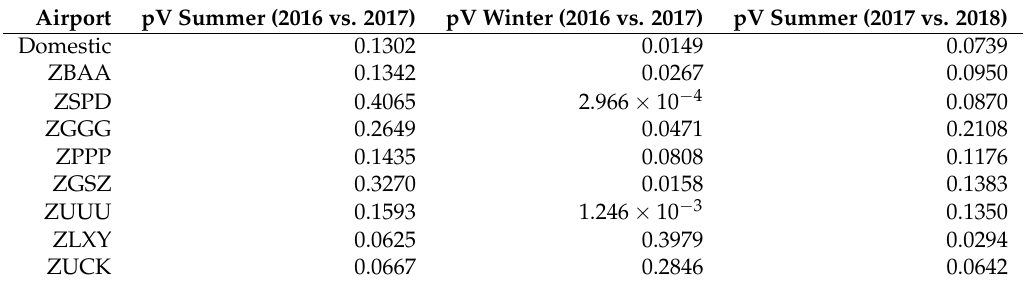
Table 2. Statistical significance of delays by seasons. The columns report the p -value of a two-sample t -test checking if the delay was significantly different between the same season of two consecutive